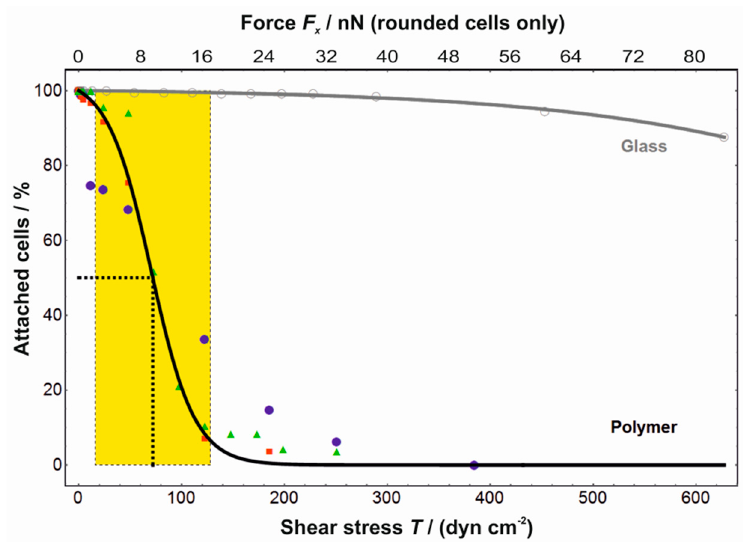
Figure 2. Quantification of the force required to detach individual L929 cells from the microgel coating in a cell-repellent state using a microfluidic approach. The fraction of remaining cells in the microchannel is a function of the shear stress T (lower abscissa) and of the shear force F x acting on individual cells with spherical morphology (upper abscissa). Note that consequently the force axis is only valid for the rounded cells on the microgel coatings, since the spherical shape assumed in the numerical calculation does not hold for the spread morphology on glass. Filled symbols denote experiments using the microgel coating ( n = 3), open symbols indicate control experiments on glass. All data sets were individually fitted with a logistic function (sigmoid curve), each yielding two parameters: the shear stress, where 50% of the cells remained ( F 50 ), and the width of the transition ( w F ). For the thermoresponsive microgel coating (black curve), the weighted averages were T 50 = (72 ± 1) dyn cm − 2 and w T = (56 ± 3) dyn cm − 2 , while on glass (grey curve) a complete cell detachment could not be achieved because of setup limitations. The shear stress needed to detach cells from glass was at least one order of magnitude higher than from the microgel coating. Fifty percent of the cells were detached at an average force of (7.9 ± 0.1) nN with a transition width of (6.6 ± 0.4) nN.